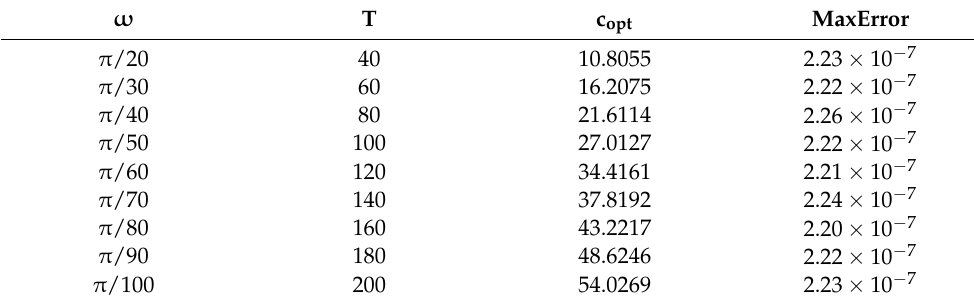
Table 8. Partial results of ω = π /10k ( k = 2, . . . ,10 ) . Table 9. Partial results of